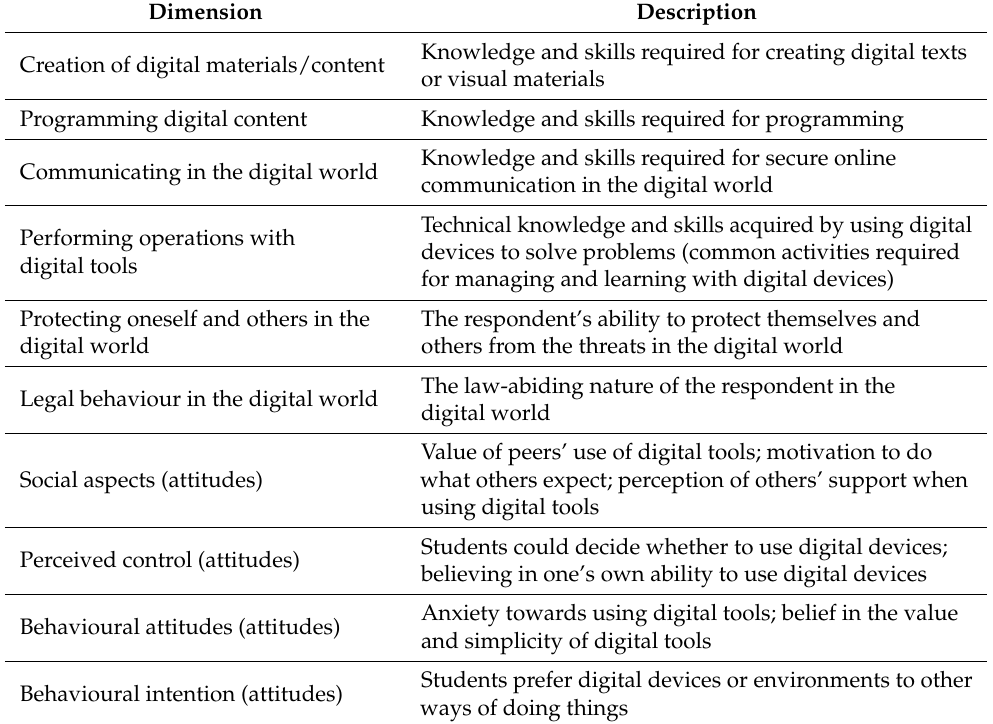
Table 1. Dimensions and descriptions of digital competence for learning